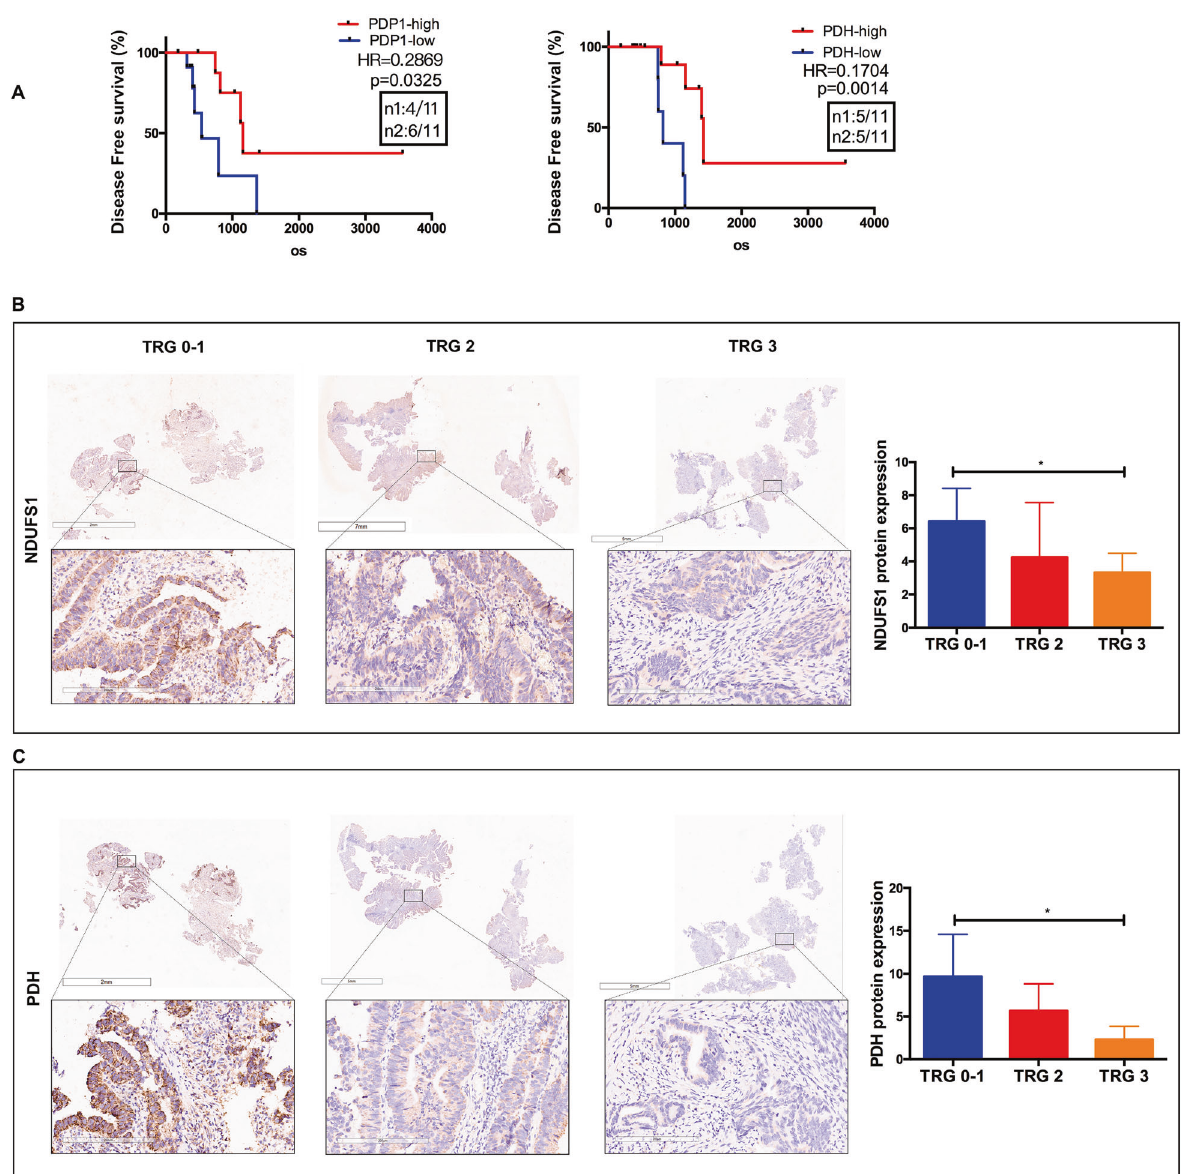
Fig. 7 Elevated NDUFS1 and PDH expression were signi fi cantly associated with better tumor regressions in patients with CRC. A Kaplan – Meier curves showing the disease-free survivals in colorectal tumor cases with low or high PDH, PDP1 expression from TCGA databases. B – C IHC analysis of NDUFS1 and PDH protein expression in patients with different TRG score. Magni fi ed areas were shown below, scale bars :2 – 7 mm. NDUFS1 and PDH expression was lower in worse TRG tissues. ( n = 3), * P < 0.05. Data are presented as the means ±